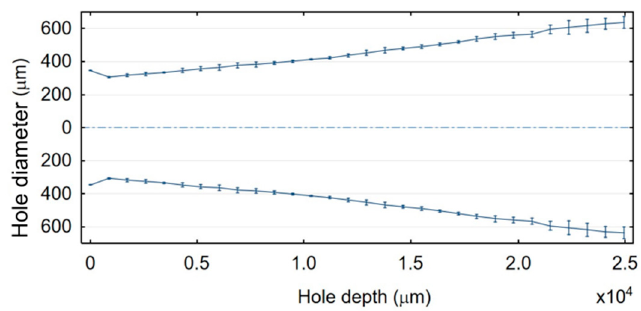
Figure 12. Profile of the through hole along its depth.